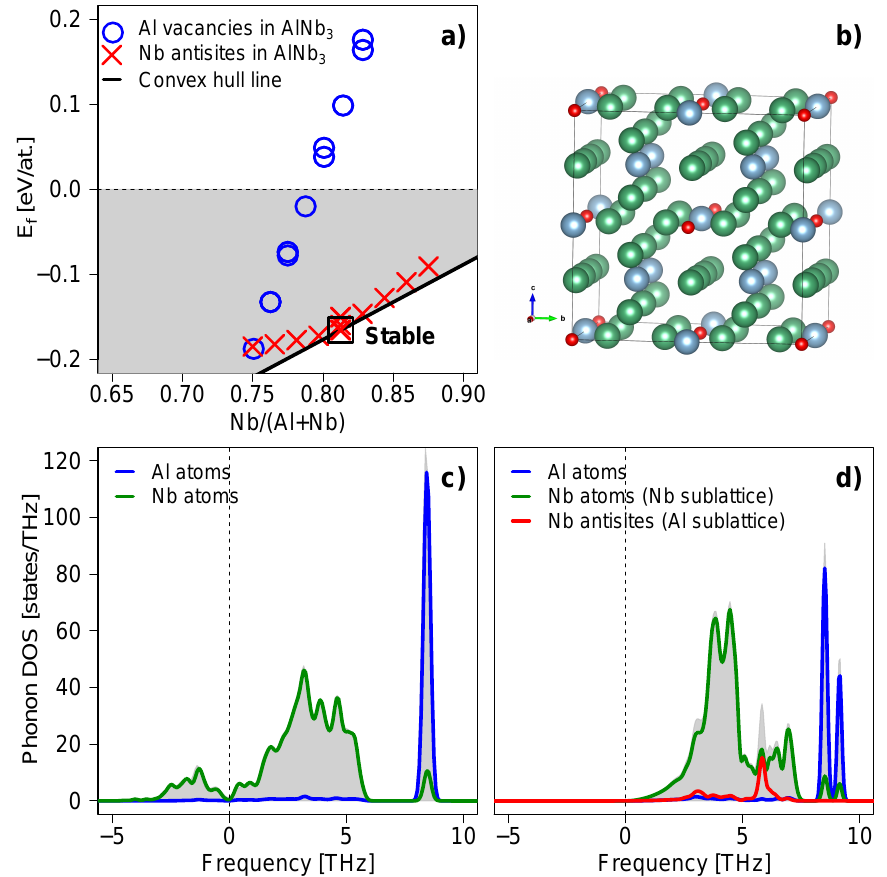
Figure 5. ( a ) Formation energy of the δ -AlNb 3 phase containing Al vacancies (circles) or Nb antisites (crosses) as a function of the Nb content. The black solid line shows the convex hull, while the shaded area denotes region for the chemically stable compounds. ( b ) The δ -Al 0.19 Nb 0.81 structural variant with ordered Nb antisites lying on the convex hull. The blue, green, and red spheres denote Al, Nb, and Nb antisite atoms, respectively. The phonon DOS of the defect-free δ -AlNb 3 ( c ) compared to that of the δ -Al 0.19 Nb 0.81 with ordered Nb antisites ( d ). The grey shaded area represents the total phonon DOS, while the solid lines show the partial contribution from Al and Nb